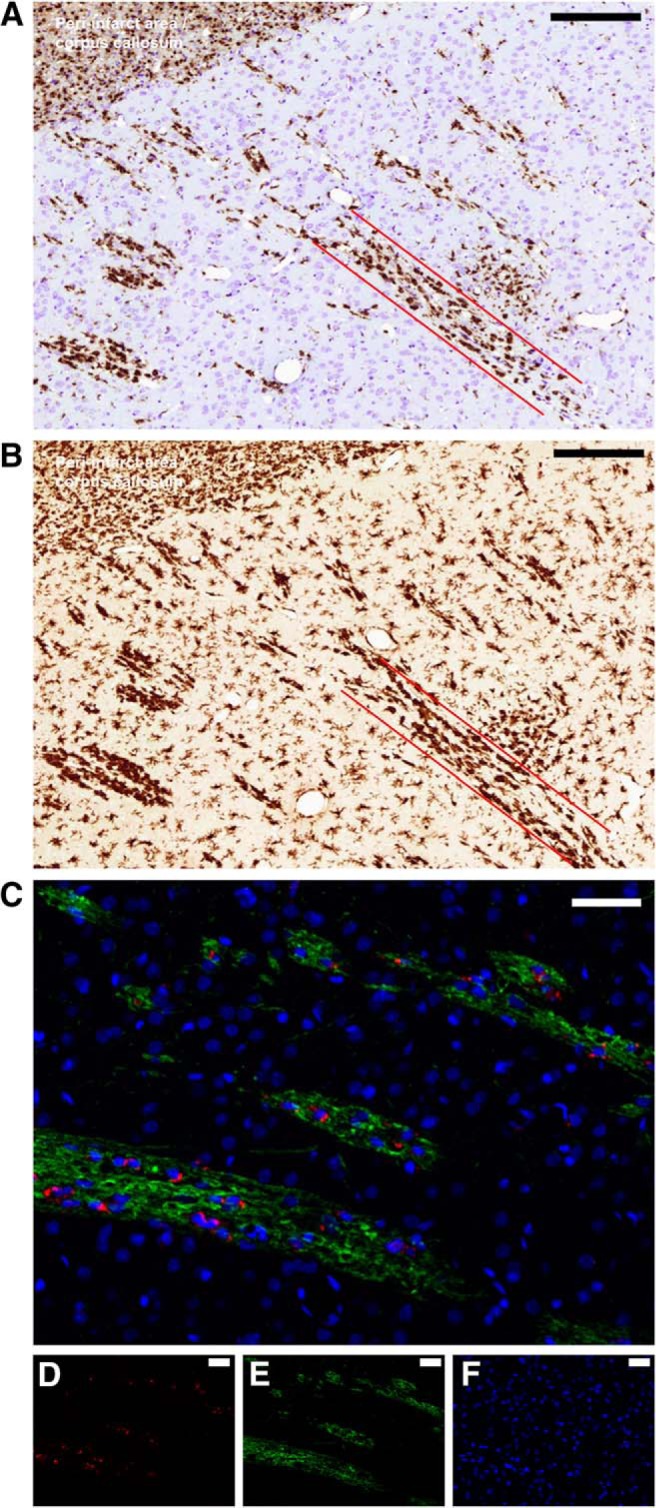
Activated microglia in the striatum are lined up along axonal bundles after cortical stroke. Immunostaining of rat striatum at post-stroke day 14 for phagocytic microglia/macrophages (CD68; A) and all microglia/macrophages (Iba1; B). C–F, Double immunofluorescence staining of rat striatum at post-stroke day 14 for phagocytic microglia/macrophages (CD68; red; D) and myelin (MBP; green; E) with DAPI (blue; F). In A, B, scale bar is 200 µm; in C–F, scale bar is 50 µm.